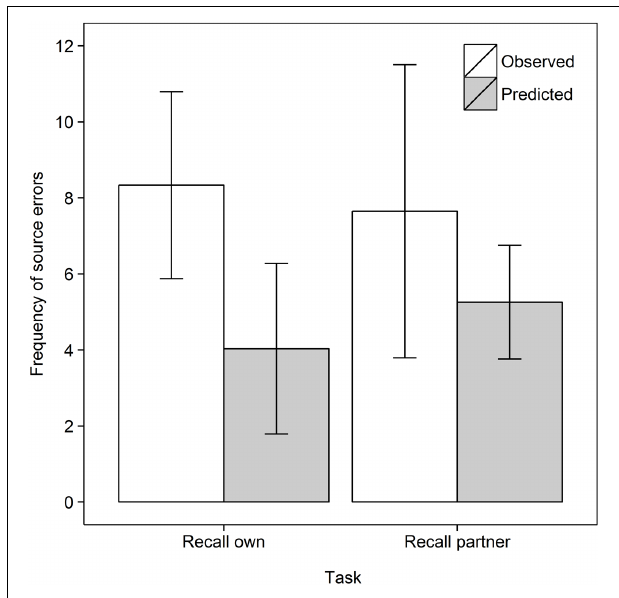
FIGURE 2 | Frequent of observed and predicted source errors in the Recall own and Recall partner task in Experiment 1. The error bars are 95% within-subjects confidence